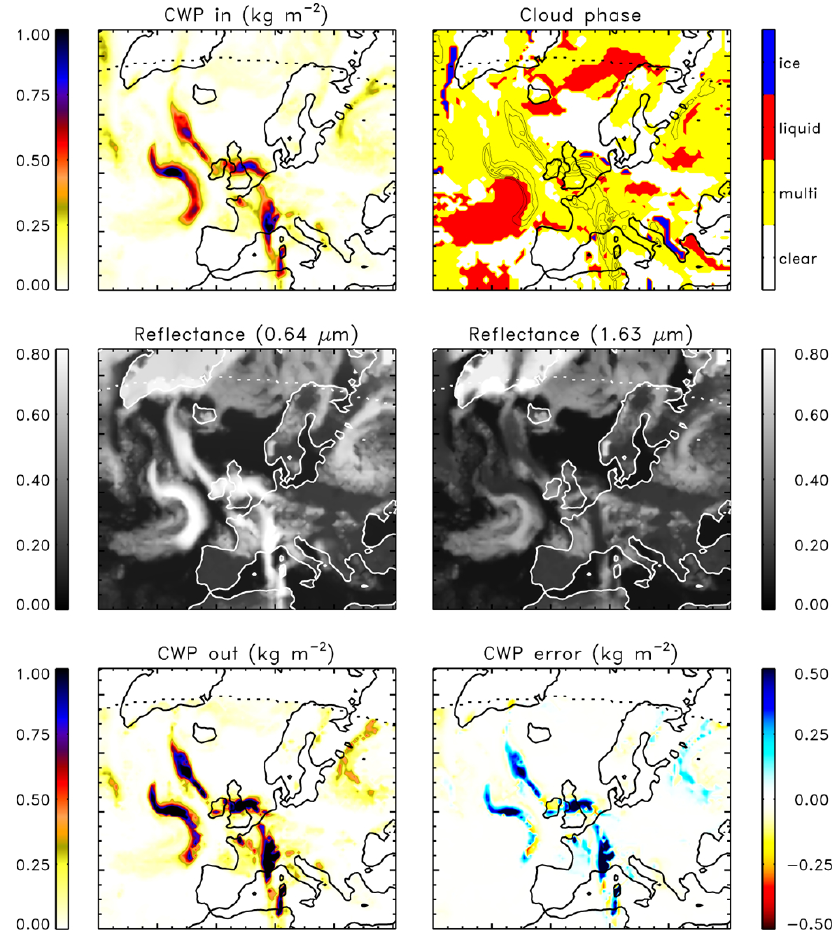
Fig. 9. Application of the simulator to a single RACMO field, for 15 May 2009, 12:00UTC. The upper left panel gives the CWP calculated by RACMO; the upper right panel gives the cloud phase at each grid point ( > 99% ice, > 99% liquid water, multi-layer, or clear), with countours tracing CWP for ease of reference; the center left panel gives the simulated reflectance at 0.64µm; the center right panel gives the simulated reflectance at 1.63µm; the lower left panel gives the retrieved CWP after the RACMO output was put through the simulator and CPP; the lower right panel gives the difference between the retrieved CWP and the RACMO CWP. In all panels the dotted line marks the area where both the solar and satellite zenith angles are less than 72 ◦ ; no retrievals are done beyond this